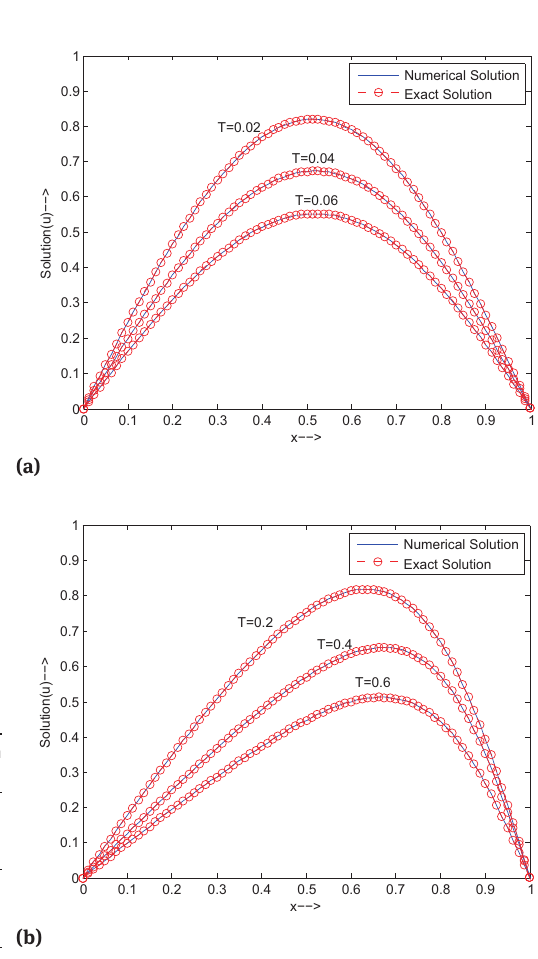
Fig. 1: Example 1: Numerical solutions at different times for Δx = 0.0125 and different values of ν and Δt , (a) ν = 1 , Δt = 0.0001 (b) ν = 0.1 , Δt = 0.001